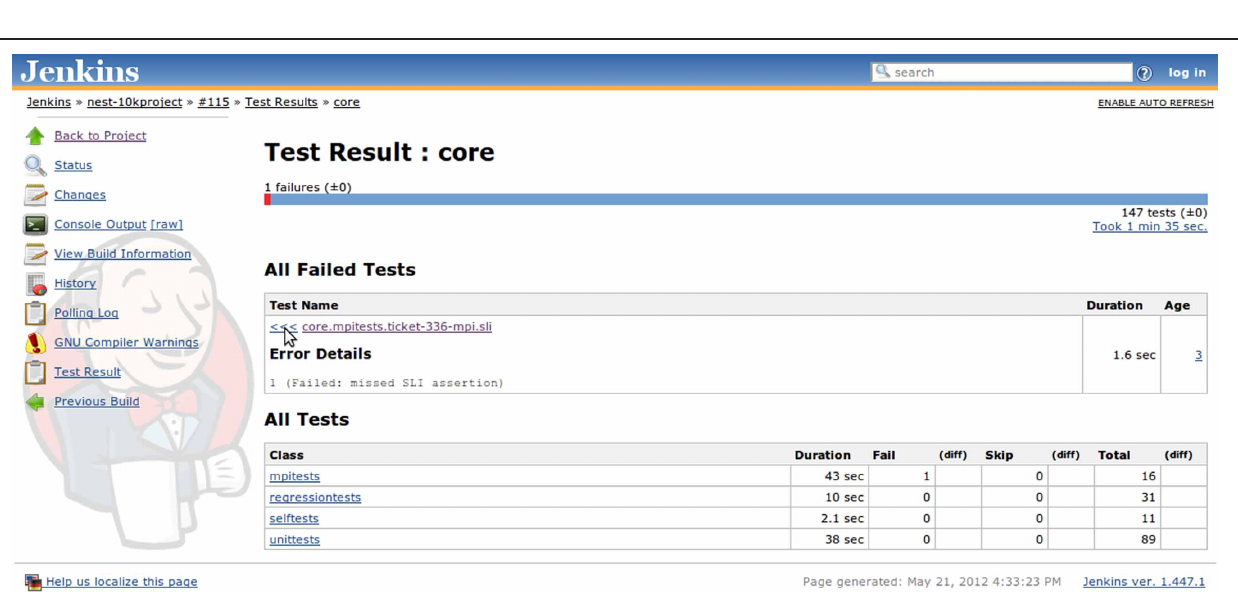
upon which information is provided by the JUnit generator) or browse to the details page which provides a full backtrace. Tests are aggregated in packages and for each package the total duration, total number of tests, as well as the amount of failed and skipped tests are reported in the summary